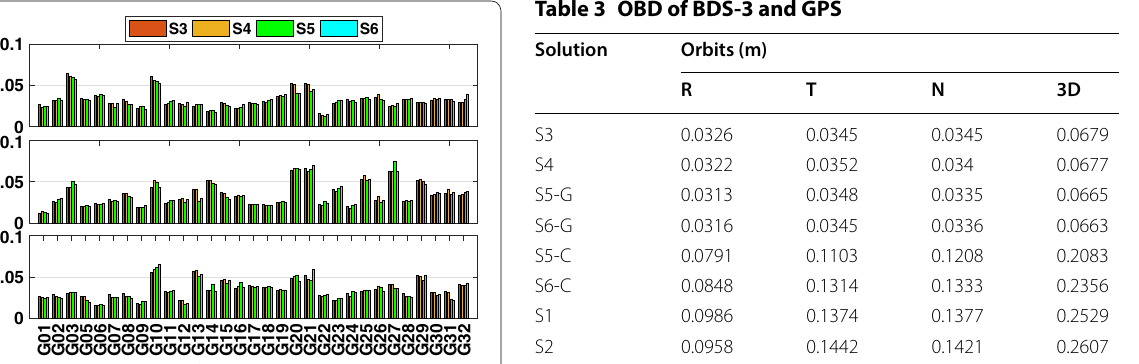
To validate further the computation efficiency for the IF and UC strategies, Table 5 shows the cost time of the six POD solutions for the first iteration and total POD pro- cessing. The statistics may not be highly strict, because a few POD tests are executed in parallel. The computation time of the UC strategy (S2, S4, and S6) is greater than